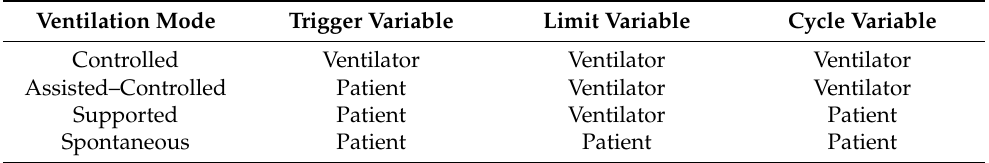
Table 2. Classification of the mechanical ventilation modes based on phase variables, adapted from [5].